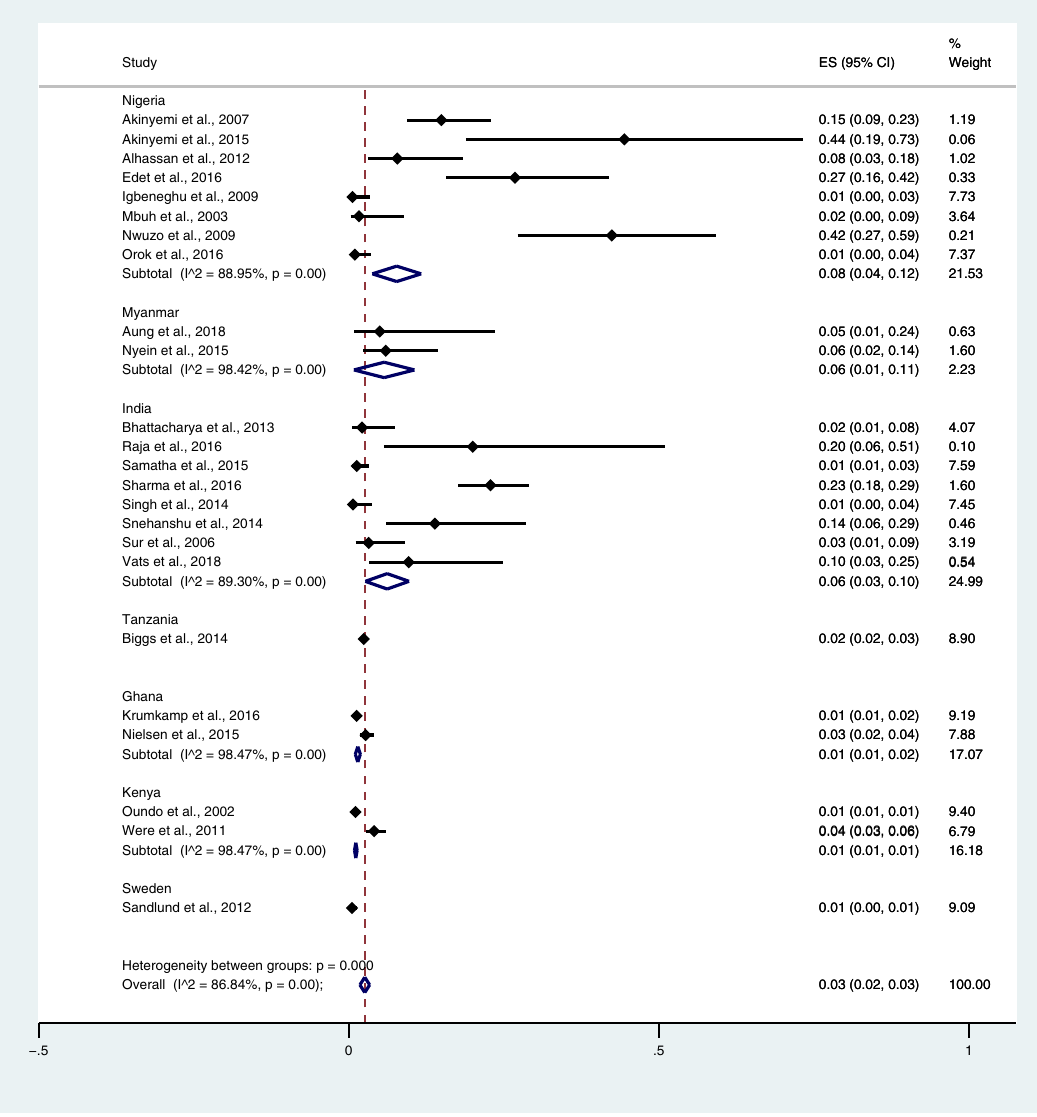
Figure 13. Prevalence of typhoidal/NTS infection among patients with malaria detected using blood cultures for the identification of Salmonella spp. infection stratified by countries. ES proportion estimate (multiply 100 units for interpreted as prevalence estimate), CI confidence interval. other acute febrile illnesses. Infections caused by typhoidal Salmonella , including S. typhi and S. paratyphi , and the associated serious complications require treatment with antibiotics, including chloramphenicol, cefixime, amoxicillin, trimethoprim/sulfamethoxazole, azithromycin, aztreonam, and cefotaxime, to prevent severe illness and death 3,114 . NTS infections do not usually require treatment with antibiotics. However, complications, such as septicemia and meningitis, require treatment with ciprofloxacin, ceftriaxone, and ampicillin, according to the WHO 3,114 . Presently, antibiotic resistance of Salmonella species is an emerging threat, so reliable diagnostic test and appropriate treatments for typhoid/non-typhoid fever are important. The present meta-analysis demonstrated that Salmonella spp. bacteremia developed in approximately 2% of patients with severe malaria. This occurrence was not much different from the Salmonella spp. bacteremia pooled prevalence of 3% in patients with non-severe malaria. Several mechanisms have been suggested to elucidate why patients with malaria may be predisposed to Salmonella spp. infection and bacteremia. First, immunosup- pression occurs during malaria infection and treatment 115 . Second, malaria can lead to hemolysis, which may predispose patients to infection with Gram-negative bacteria, such as typhoidal Salmonella /NTS spp. 69 . Third, changes in iron storage metabolism from malaria-induced hemolysis cause neutrophil dysfunction and increased susceptibility 116–118 . Increased free iron from hemolysis may also promote the survival of Salmonella spp. 19 . Fourth, the sequestration of parasitized red blood cells in the intestine causes reduced blood flow in the mucosal gut barrier, which increases intestinal susceptibility to bacterial infection 119,120 . The high rate of NTS